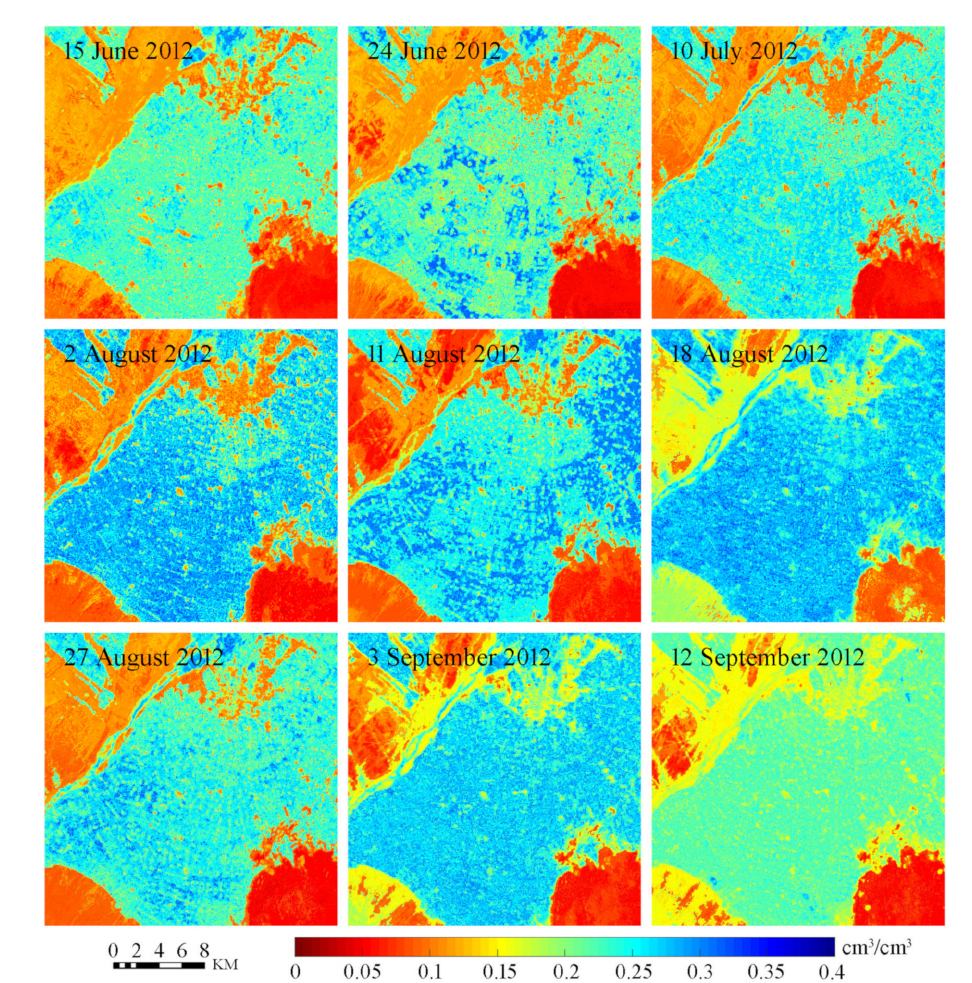
Figure 12. The results of soil moisture mapping by RF based on combination H (LST, NDVI, and SEE). The RF machine learning method has high prediction accuracy and tolerance for anomalies and noise in the data, with rare over-fitting in practical application. RF has the advantage of learning the relationships between soil moisture and auxiliary variables, espe- cially nonlinear, indirect relationships, based on a large number of samples.